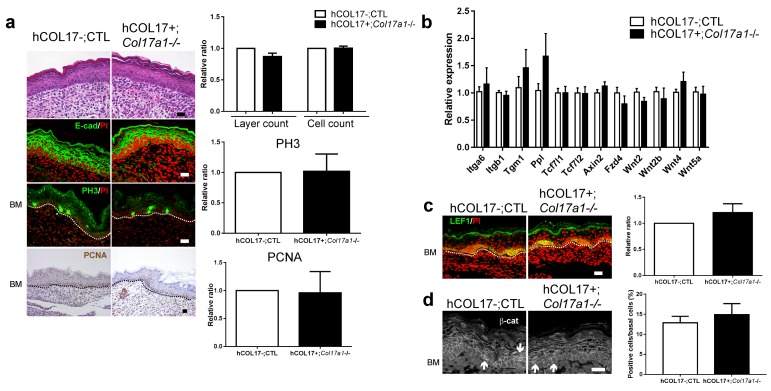
Induction of human COL17 abrogates epidermal hyperproliferation and the expression of Wnt-β-catenin signaling molecules in neonatal Col17a1−/− IFE.(a) H&E, E-cad, PH3 and PCNA staining of IFE skin specimens from Col17a1+/+ or Col17a1+/- (as hCOL17-; CTL (control)) and hCOL17+; Col17a1−/− littermate mice at P1. Quantification of epidermal layers, epidermal cell counts, and PH3- and PCNA-positive cells (n = 4). Scale bar: 20 μm. (b) Gene expression of Wnt-related molecules in IFE skin samples from hCOL17-; CTL and hCOL17+; Col17a1−/− littermate mice at P1 (n = 4). (c) LEF1 staining of IFE skin samples from hCOL17-; CTL and hCOL17+; Col17a1−/− littermates at P1 (n = 4). Scale bar: 20 μm. (d) β-catenin staining of IFE skin samples from hCOL17-; CTL and hCOL17+; Col17a1−/− littermates at P1 (n = 4). Nuclear β-catenin is indicated with arrows. The number of nuclear β-catenin-positive cells. Scale bar: 20 μm. The data are the means ± SE. Student’s t-tests.